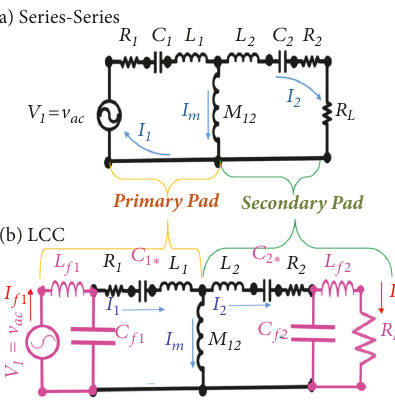
Figure 9: Series-series (a) and LCC (b) compensation topologies.